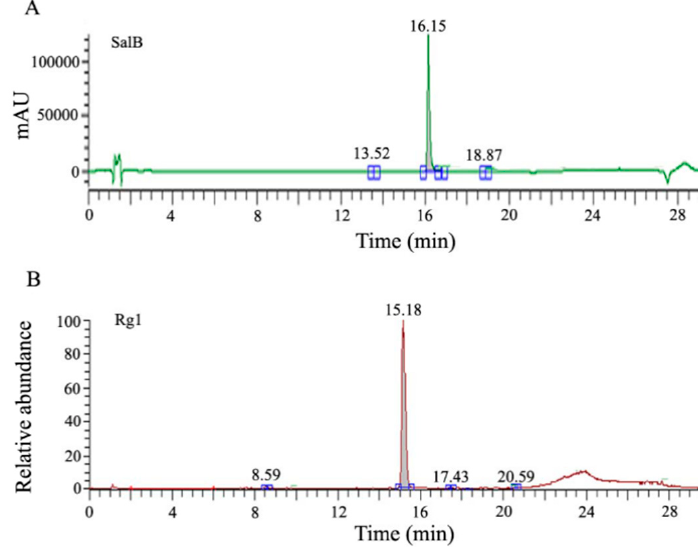
Figure 1. Representative chromatograms of salvianolic acid B (SalB) and ginsenoside Rg1 (Rg1). ( A ) The purity of SalB was 98.46%; and ( B ) the purity of Rg1 was